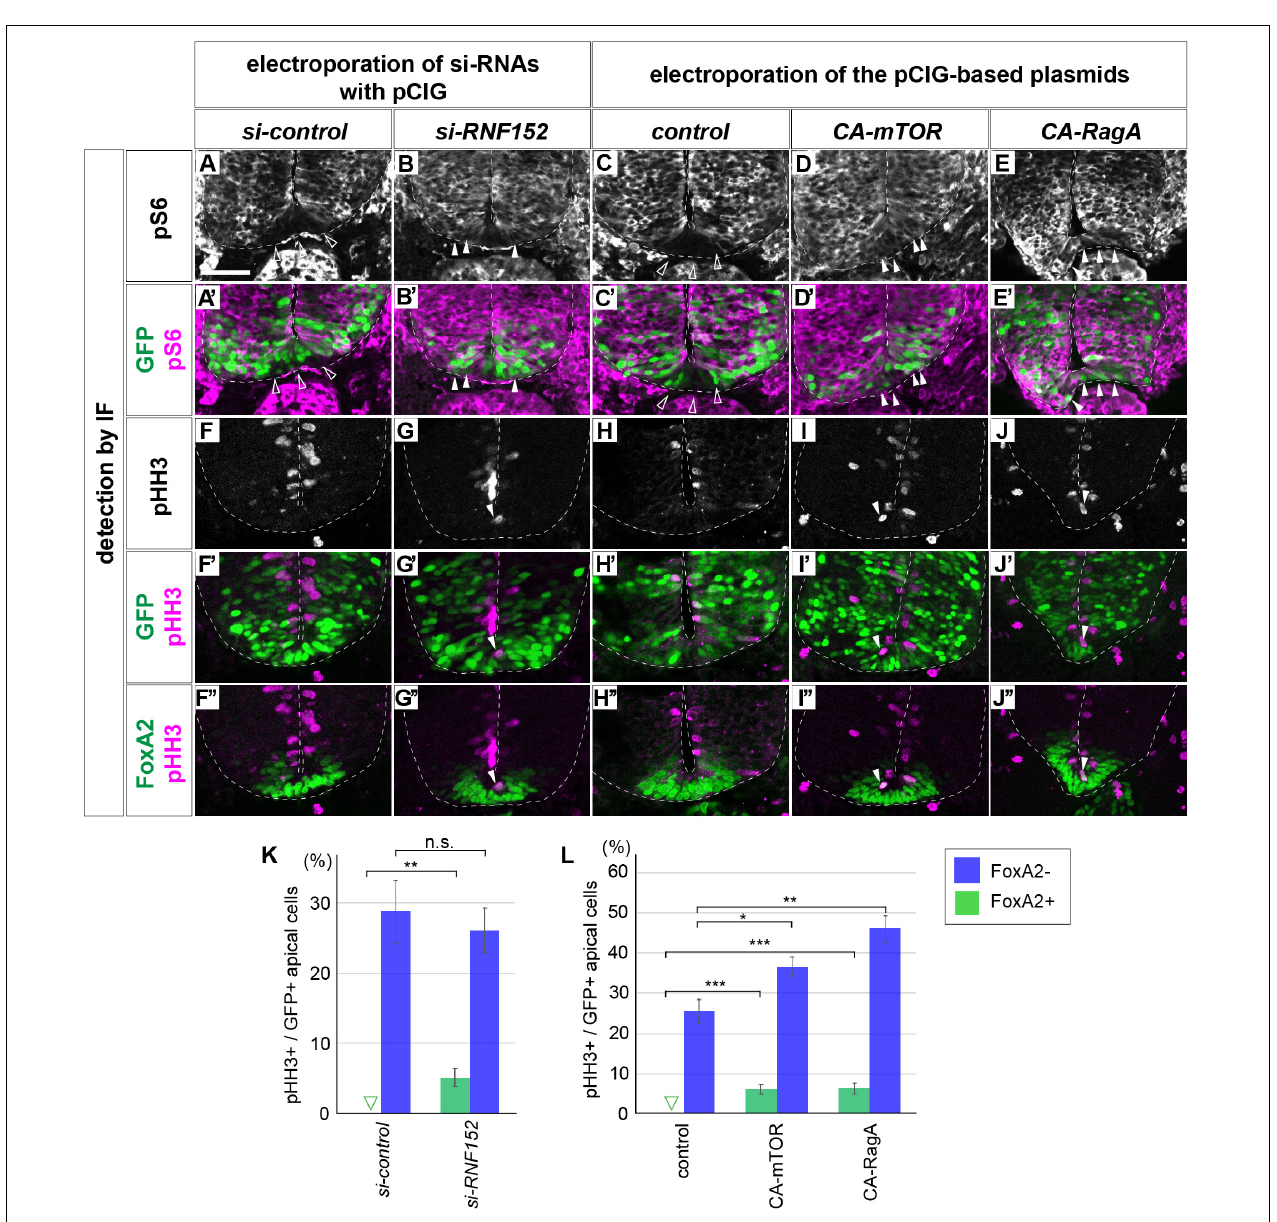
FIGURE 6 | Blocking RNF152 expression or activation of mTOR signal leads to aberrant pS6 upregulation and cell division in the floor plate. (A–B’,F–G”) Knockdown of RNF152 by si-RNA caused aberrant mTOR activation and the appearance of pHH3-positive cells. si-control (A,A’,F,F’,F”) or si-RNF152 (B,B’,G,G’,G”) were electroporated in the FP at HH stage 10 and embryos were analyzed at 48 hpt with pS6 (A–B’) , pHH3 (F–G”) , FoxA2 (F”,G”) , and GFP (A’,B’,F’,G’) antibodies. (C–E’,H–J”) Activation of mTOR signal induces aberrant cell division. The plasmids of control pCIG (C,C’,H,H’,H”) , CA-mTOR (D,D’,I,I’,I”) , or CA-RagA (E,E’,J,J’,J”) was electroporated in the FP and analyzed with pS6 (C–E’) , pHH3 (H–J”) , FoxA2 (H”–J”) , and GFP antibodies (C’,D’,E’,H’,I’,J’) . The affected areas are indicated by filled arrowheads and outlined arrowheads. Scale bar = 50 µ m. (K,L) Quantitative data for (F,F’,G,G’) in (K) and (H,H’,I,I’,J,J’) in (L) . The pHH3-positive cells in FoxA2/GFP double-positive cells (FoxA2+) and in FoxA2-negative (FoxA2–)/GFP-positive cells in the apical domain were counted. The outlined triangles indicate zero (0). ∗ p < 0.05, ∗∗ p < 0.01, ∗∗∗ p <